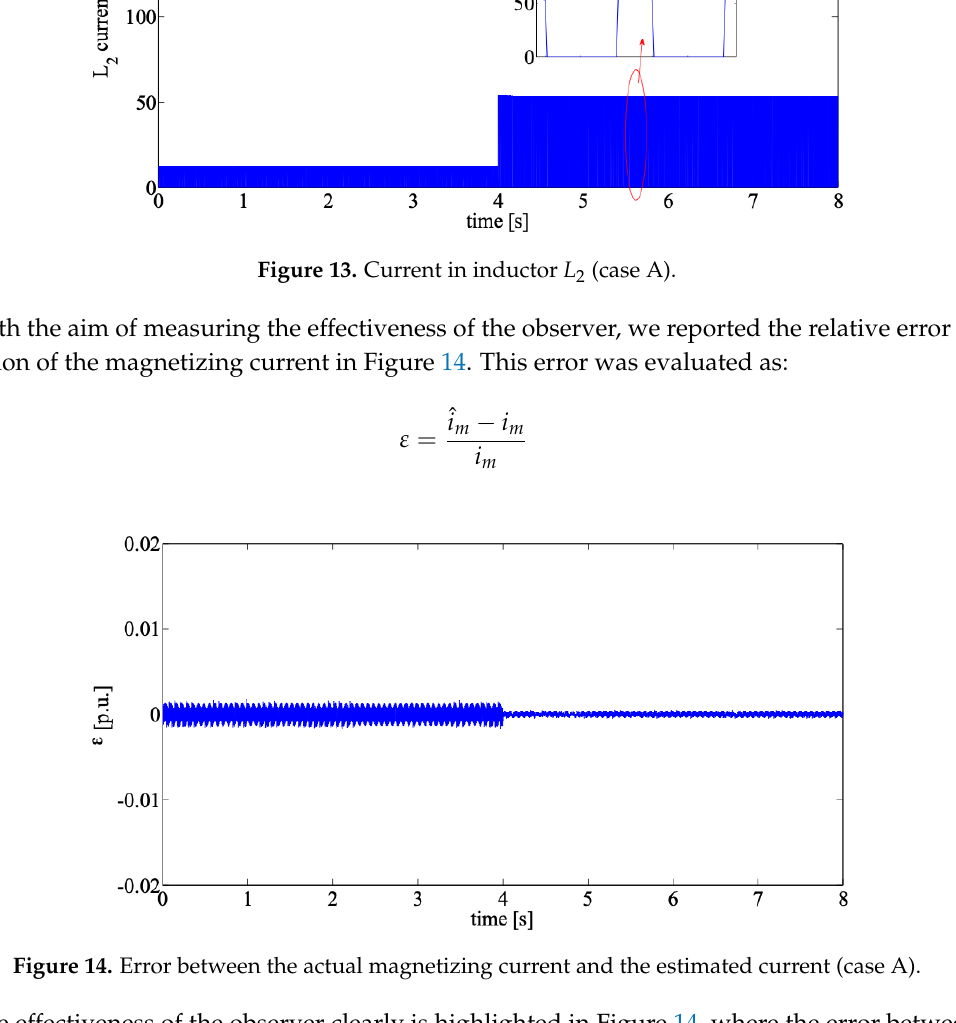
Figure 14. Error between the actual magnetizing current and the estimated current (case A).